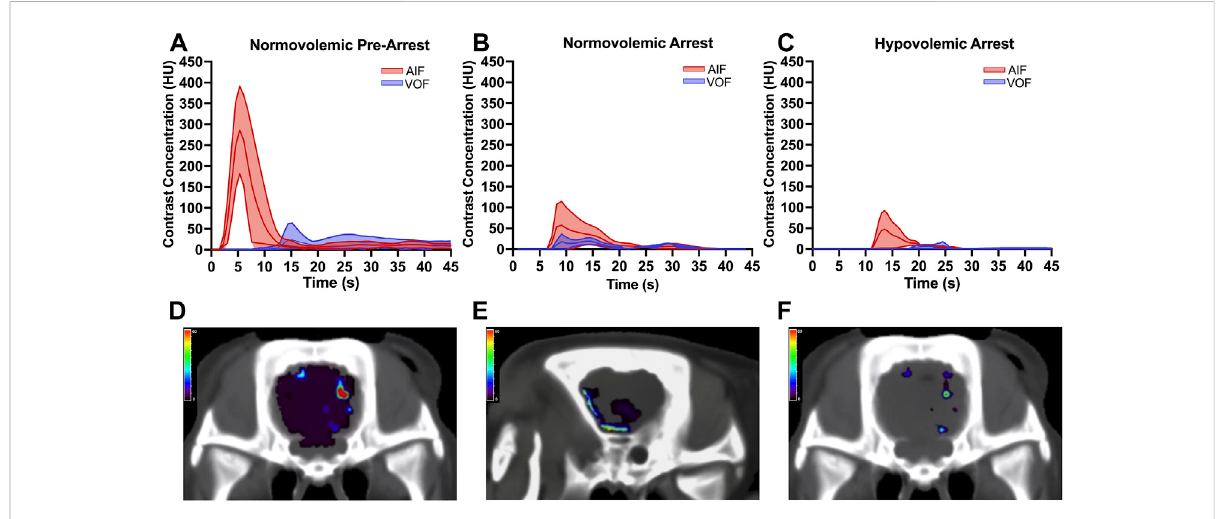
FIGURE 5 | Arterial input function (AIF) and venous output function (VOF) curves derived from change in cerebral tissue contrast concentration over time measured in Houns fi eld units (HU) using the standardized region-of-interest tool for the internal carotid artery and internal jugular vein for (A) normovolemic pre-arrest, (B) normovolemic arrest, and (C) hypovolemic arrest. Data was collected from all animals in each group. The central line graphed over time represents the mean and the shaded area represents the 95% con fi dence interval. The arrest animals underwent computed tomography acquisition following 5 min of open cardiac massage (OCM). Corresponding heatmaps demonstrate the cerebral blood fl ow (CBF) during OCM, which is measured by the slope of the AIF, for (D) normovolemic pre-arrest, (E) normovolemic arrest, and (F) hypovolemic arrest. The heat map legend represents the CBF measured in ml/min/100 g using red to represent the highest CBF and purple to represent the lowest CBF.